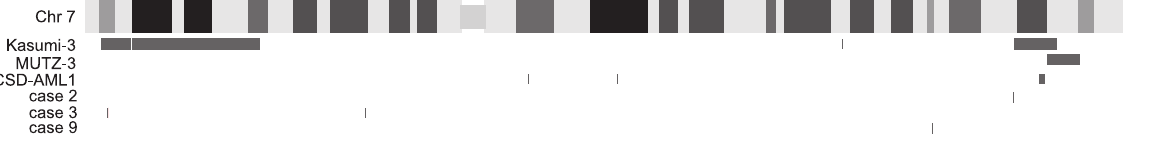
Figure 1. Overview of deletions in cell lines and patients. Chromosome view of chromosome 7 deletions in the cell lines Kasumi-3, MUTZ-3 and UCSD-AML1 and in cases 2, 3 and 9. Deletions are indicated using grey